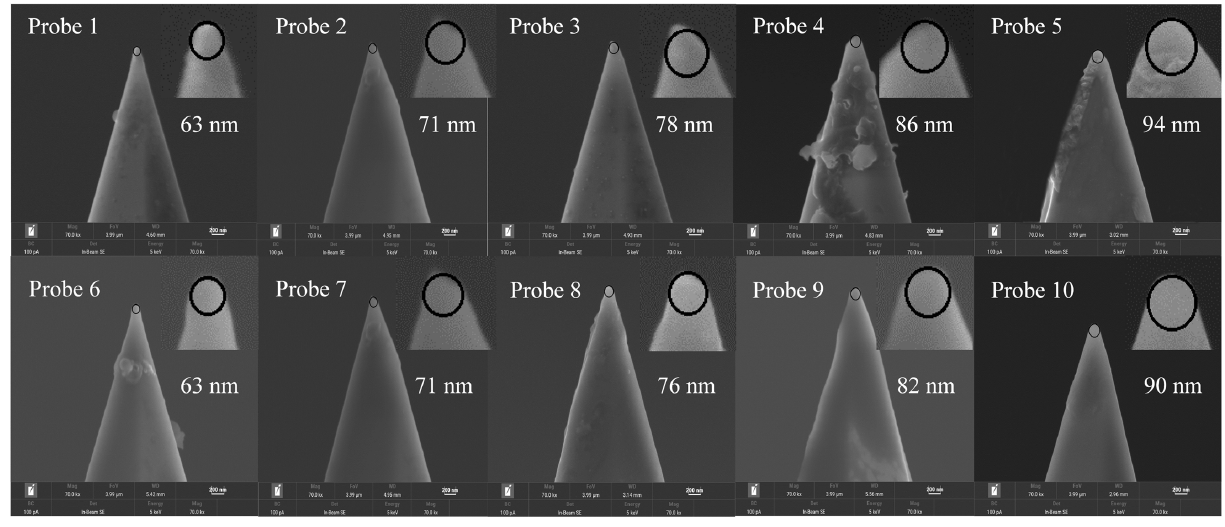
Figure 4. Wear tip morphology of Probes 1~10.